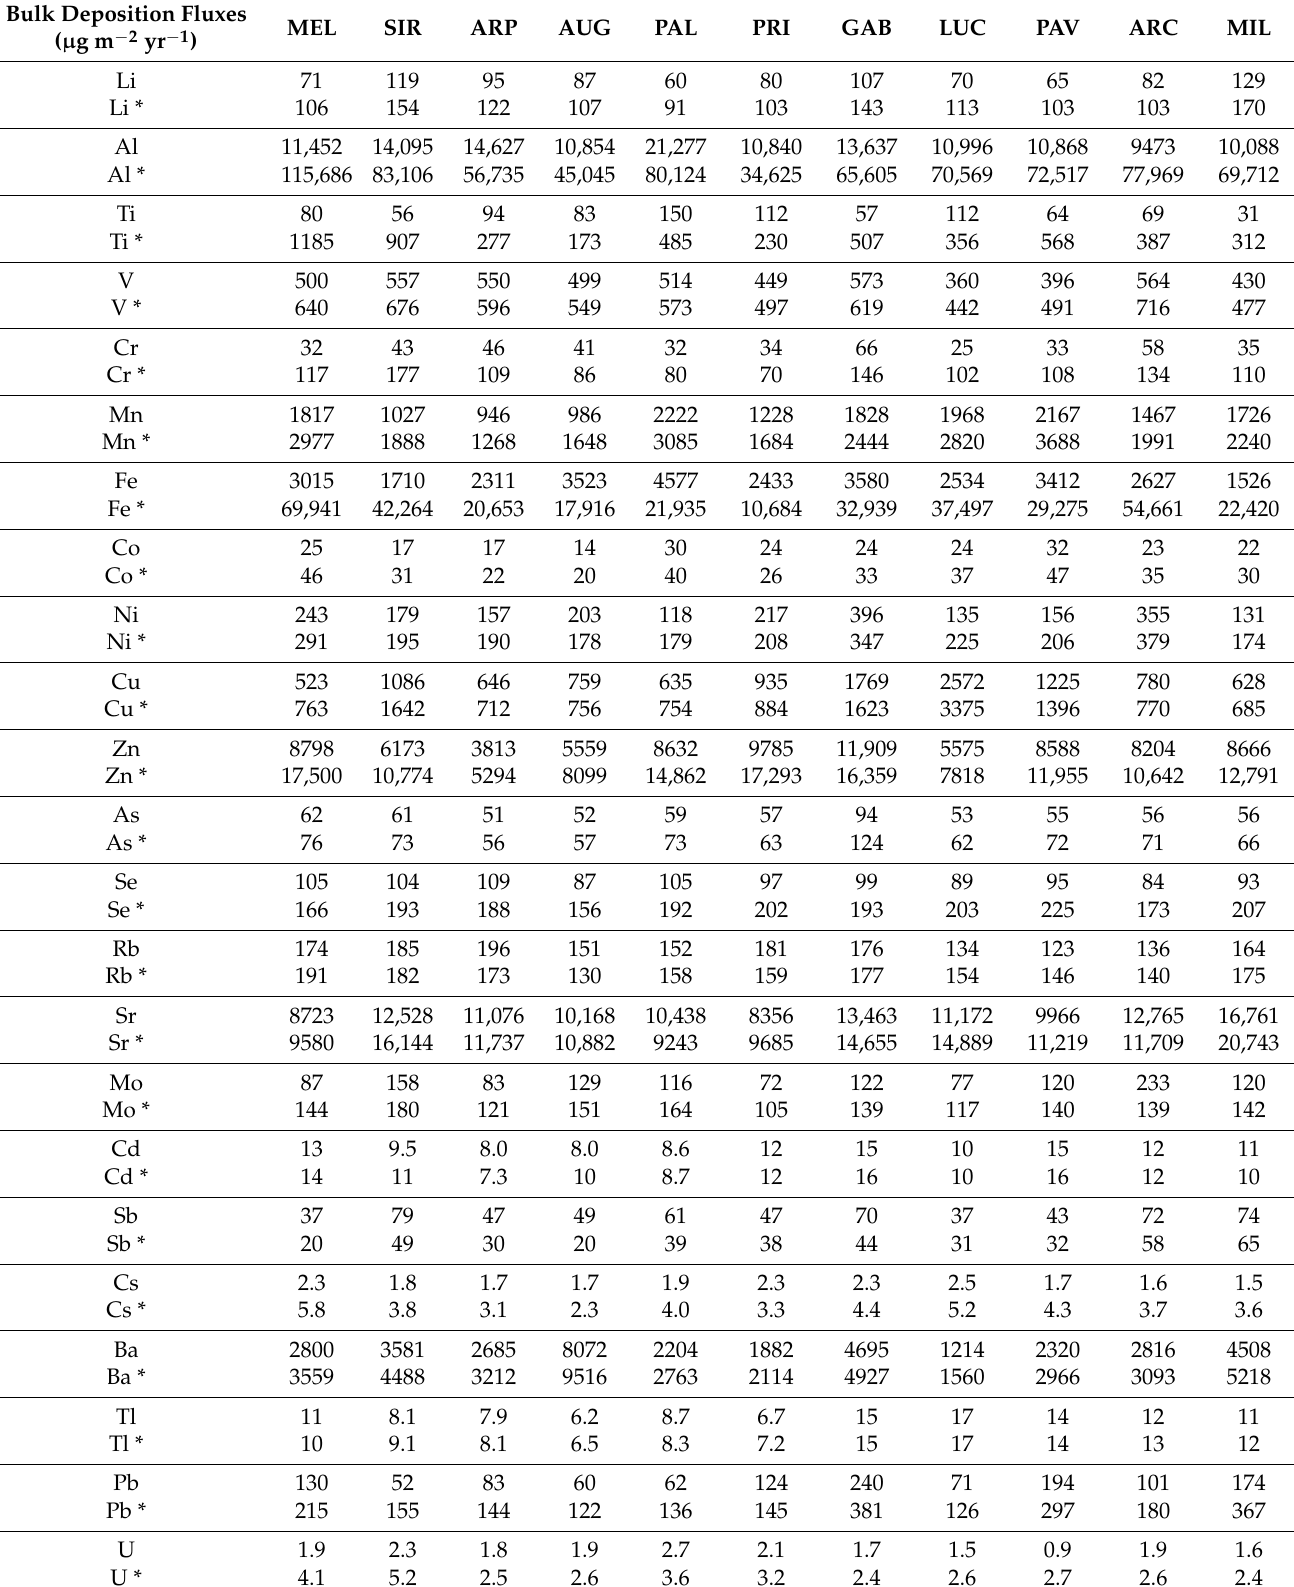
Table 2. Annual bulk atmospheric deposition fluxes ( µ g m − 2 yr − 1 ) for trace elements in both the study areas. Elements with * are relative to the unfiltered